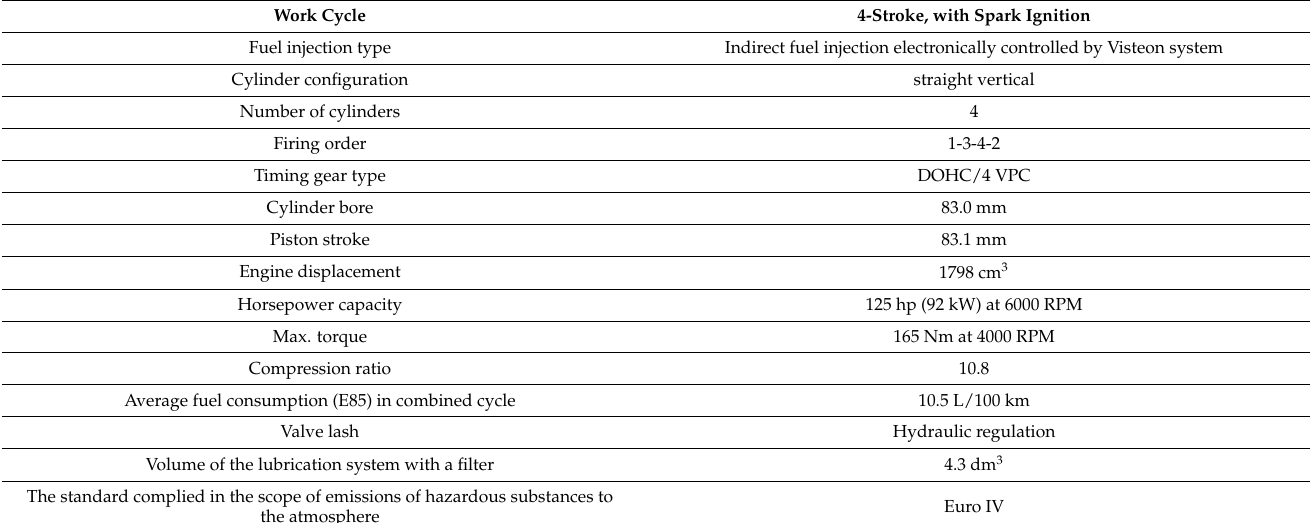
Table 3. Selected technical parameters of the FORD 1.8 L Duratec-HE PFI FFV (125 PS) MI4